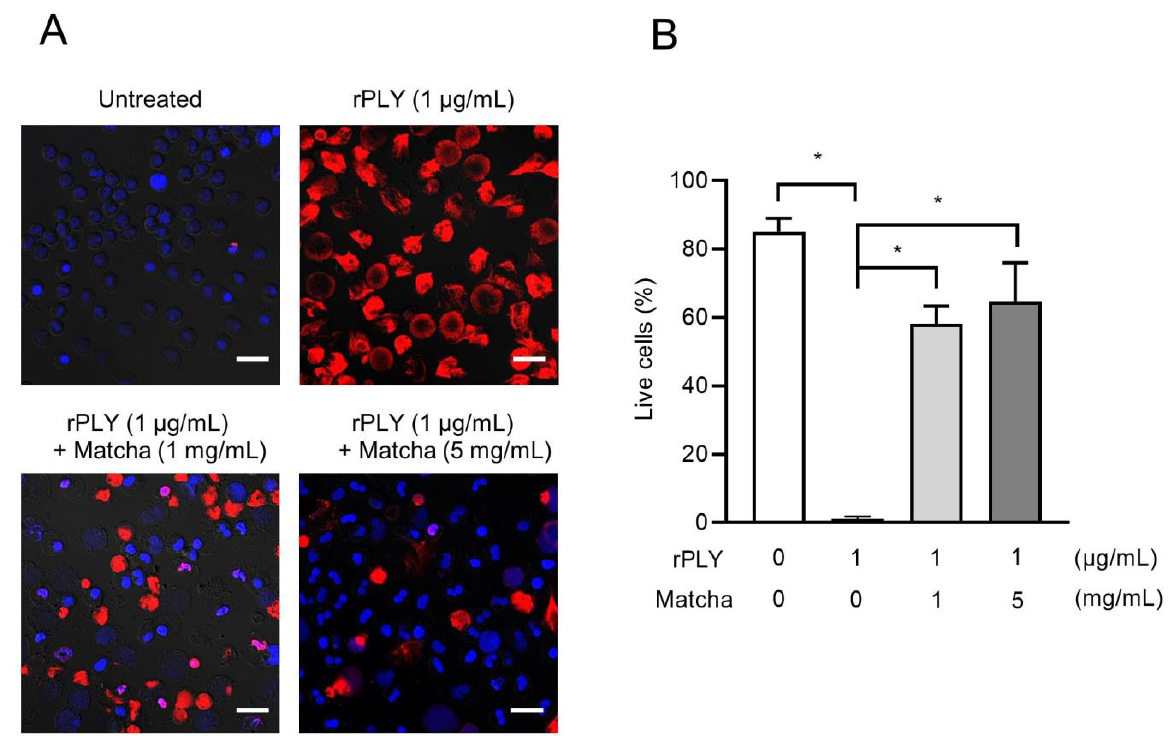
Figure 3. Matcha supernatants attenuate PLY-mediated neutrophil death. ( A ) Human neutrophils were treated with rPLY (1 µ g/mL) in the presence or absence of matcha supernatants (1 and 5 mg/mL) at 37 ◦ C for 1 h. Representative fluorescence images of cells stained by Hoechst 33342 (viable cells; blue) and ethidium homodimer III (necrotic cells; red) are shown. Scale bars: 20 µ m. ( B ) The percentage of Hoechst 33342-positive cells was calculated. Data are presented as the mean ± SD of quintuplicate determinants and were evaluated using one-way analyses of variance with Dunnett’s multiple-comparison test; * p < 0.05 versus the PLY only-treated group.